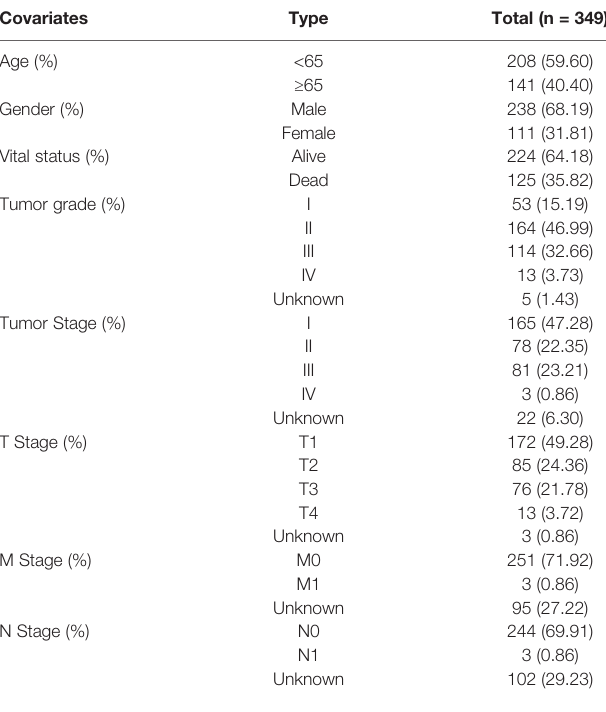
TABLE 1 | Clinical characteristics of the HCC patients in the TCGA